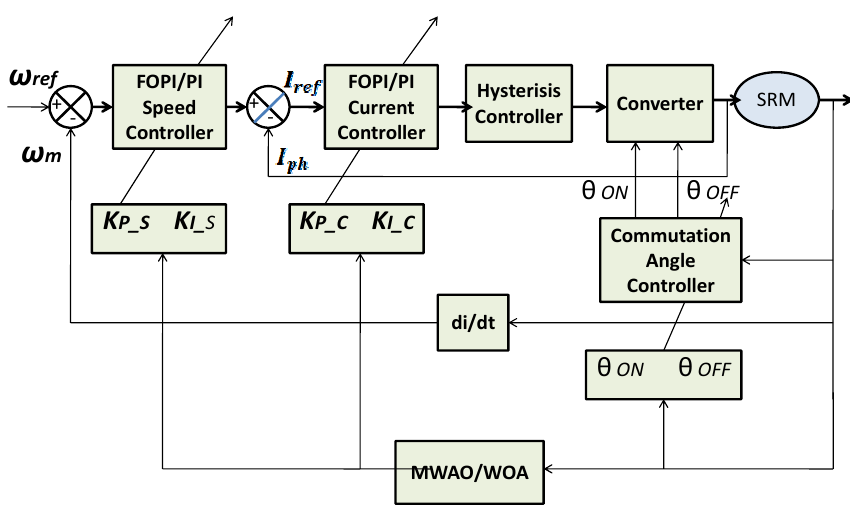
Figure 2. Multiobjective optimized double close loop MWAO FO-PI controller for control of SRM.